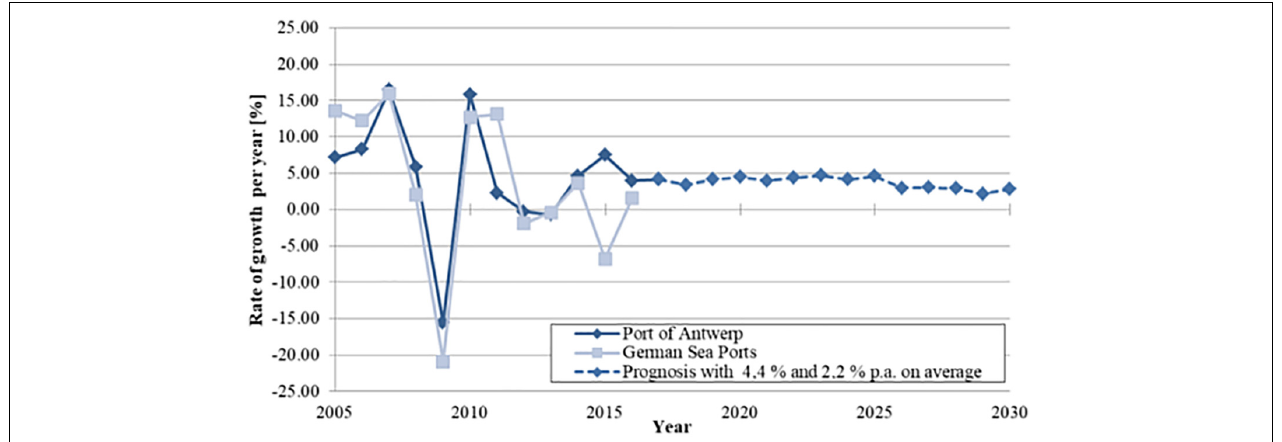
FIGURE 3 | Development of growth rates for handled containers at Port of Antwerp and German sea ports with data from Bundesministerium für Verkehr und digitale Infrastruktur (2017), Havenbedrijf Antwerpen NV (2018).